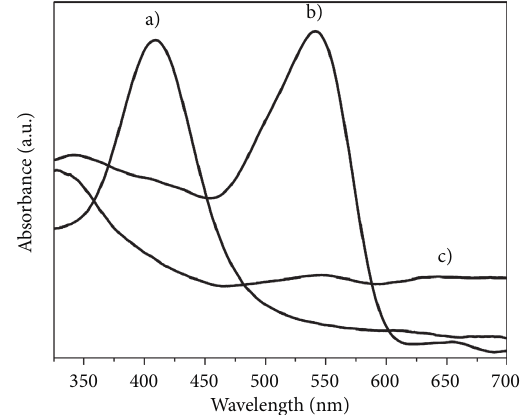
Figure 3: UV-Vis spectrum of (a) silver nanoparticles, (b) copper nanoparticles, and (c) copper-soybean